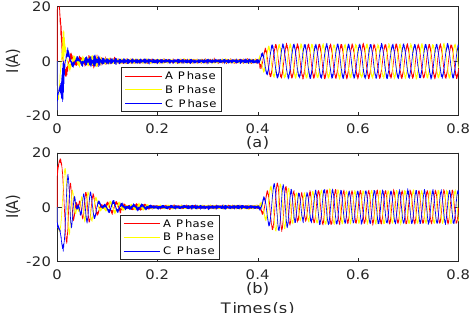
Figure 28. Three phase current response process under two control methods. ( a ) Current response under the proposed VPDPI control. ( b ) Current response under the PI control.